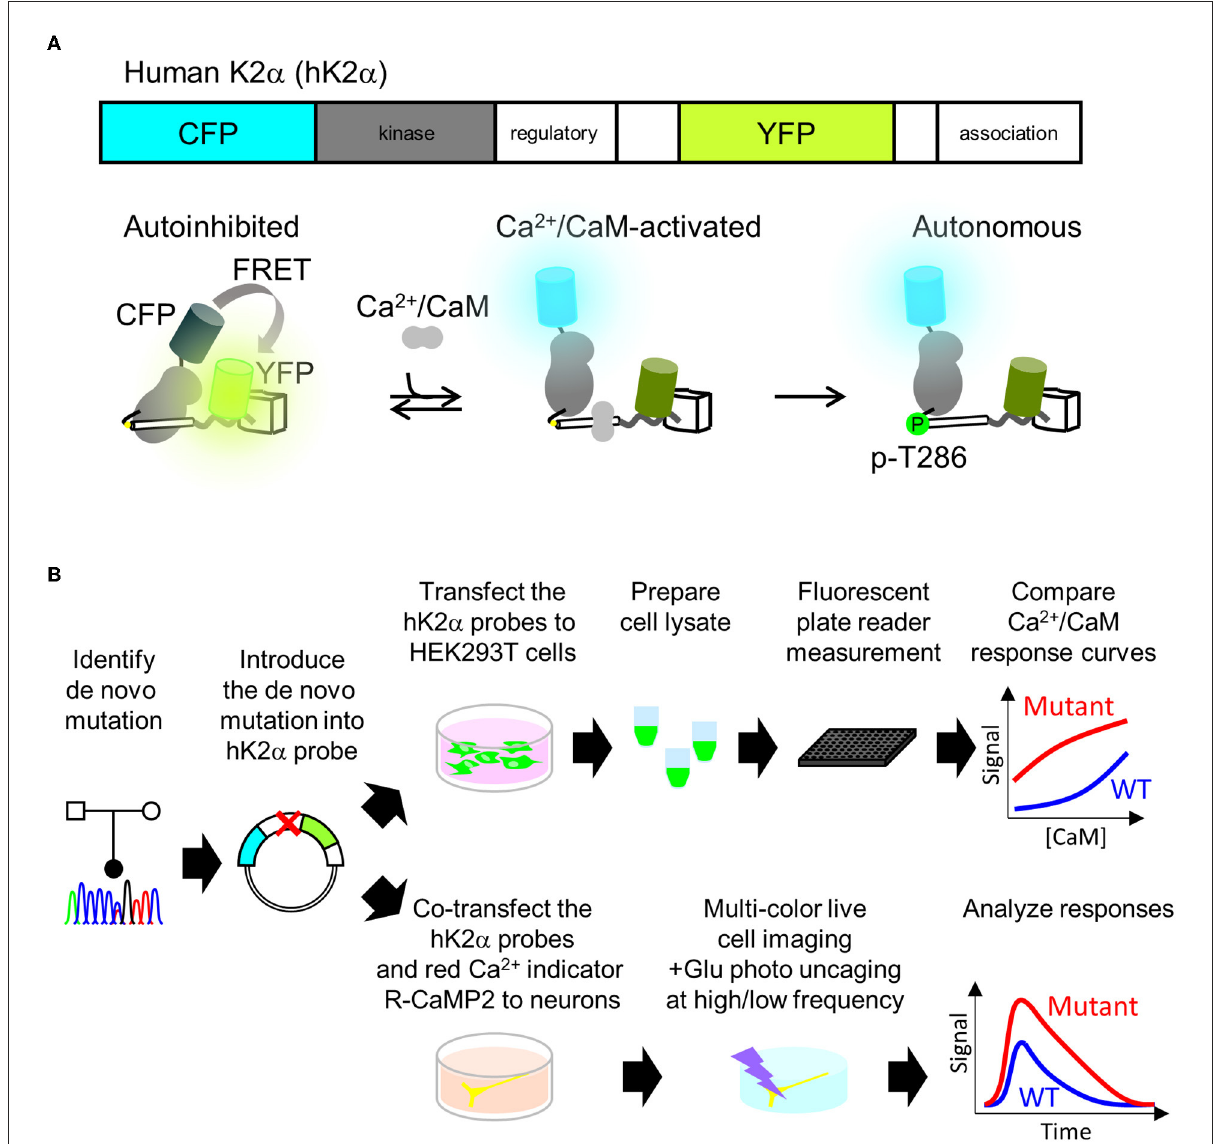
FIGURE2 Plate reader FRET assay and multi-probe live neuron imaging analysis pipelines for analyzing de novo mutations in CAMK2A. (A) human CaMKII α activation FRET probe hK2 α . Schematics of primary structure (top) and expected conformational changes (bottom) of human CaMKII α